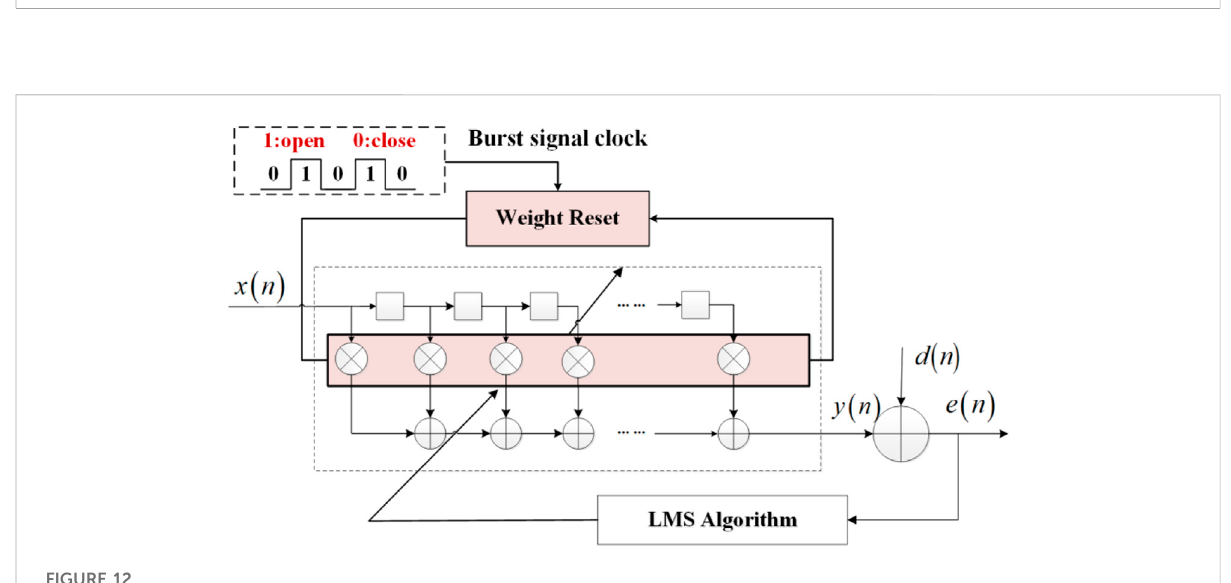
FIGURE 12 Algorithm fl ow chart based on timing